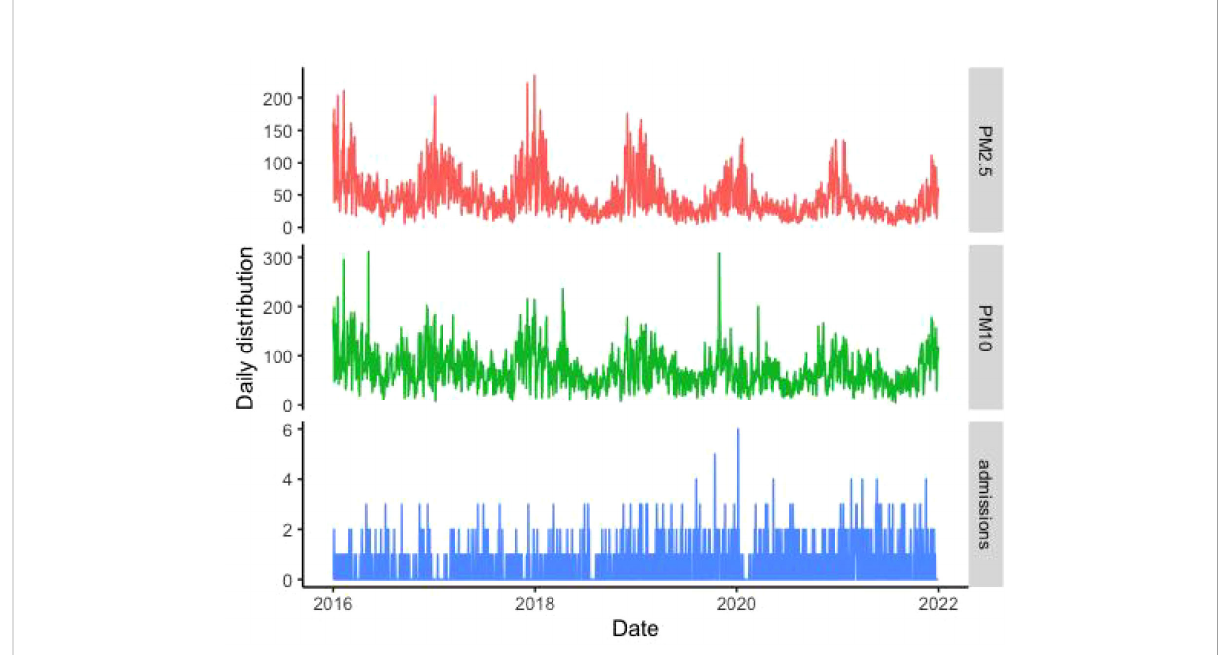
FIGURE 2 The time series of PM 2.5 , PM 10 , and SS hospitalizations in Hefei from 2016 to